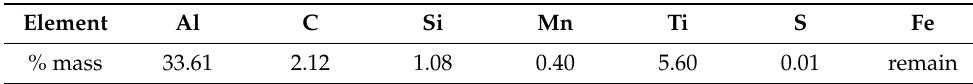
( f ) Figure 7. Self-destruction of different types of high-aluminum cast iron within 7 months after casting: Ti—titanium addition, B(HT)—boron modification and after heat treatment, KH—know-how of author; other samples were